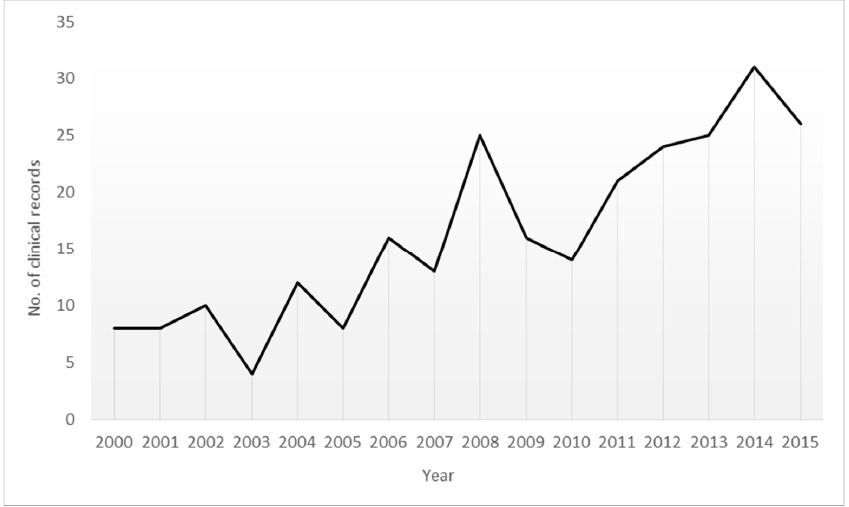
Figure 1. Progression of clinical records of the homosexual and bisexual population (2000–2015).